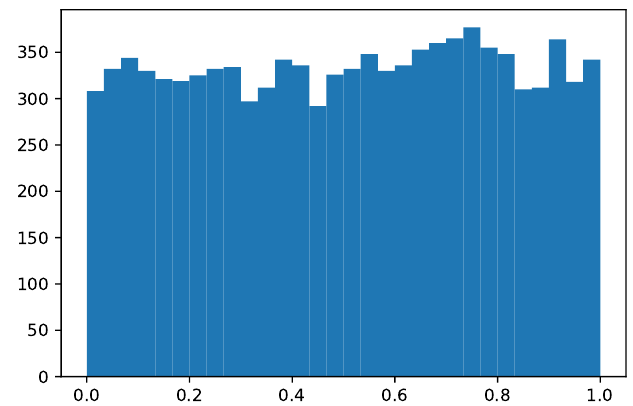
Fig. 92.— Histogram for our array of random numbers